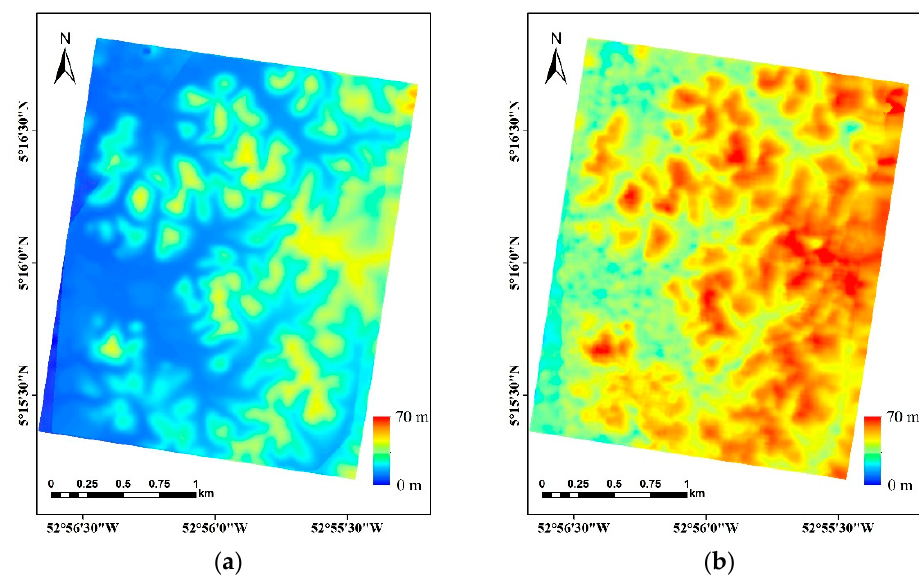
Figure 2. LiDAR data of study area. ( a ) DTM products of LiDAR, ( b ) DSM products of LiDAR. The forest AGB field survey data collected based on forestry censuses also comes from CIRAD. The forestry censuses were conducted in 2009 and 2010 [39]. During the field survey, the 16 fixed plots were set up in the study area, including 15 plots (No. 1–15) with the size of 250 m × 250 m and 1 plot (No. 16) with the size of 500 m × 500 m (Figure 1c). In order to increase the number of sample plots for statistical analysis like the relationships between forest AGB and features for estimation, the field survey data of AGB sample plots used in this paper were sub sampled into 85 in total, which were divided from the fixed plots. The division strategy (Figure 1c) was as follows: Each fixed plot (No. 1–15) was divided into 4 sub sample plots (125 m × 125 m), with a total of 60 sub sample plots and No. 16 fixed plot was divided into 25 sub sample plots (100 m × 100 m). The field survey data includes the DBH of each tree in a fixed plot (DBH > 10 cm), which was used to calculate the biomass of each tree with allometric growth functions according to different tree species. The methods and more details for AGB calculation were given in the refer- ences [39,43]. The AGB (Mg ∙ ha − 1 ) of each sub sample plot was the sum of that of each tree in the sub sample plot. The mean forest AGB of the 85 sub sample plots ranges from 250 to 450 Mg ∙ ha − 1 , and the details information of the forest AGB ground truth data are shown